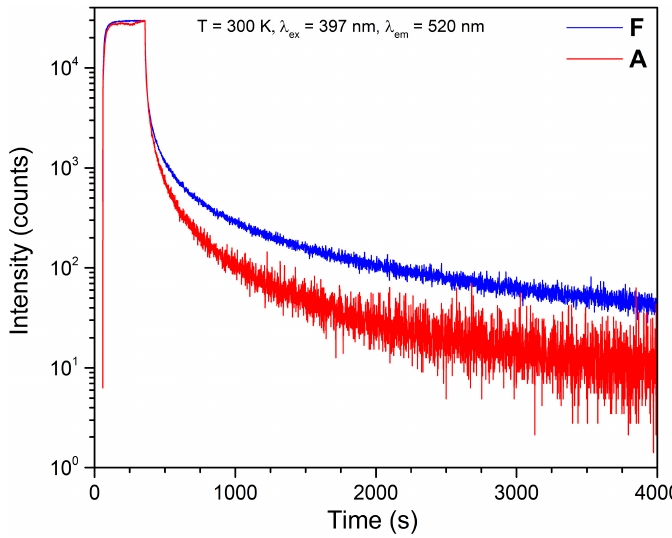
Figure 10. Decay curves of samples A and F. The decay curves were analyzed to extract decay-lifetime constants using fitting with double exponential (Equation (1)). where I 0 is the initial intensity, t is time, A1 and A2 are the amplitude of the exponents, and τ 1 and τ 2 are the decay lifetimes. The results of the fitting are shown in Table 1. The double exponential fitting gave quite big fitting error to χ 2 and, to reduce it, we carried out four exponential fittings. Table 1. Exponential-fitting results. Sample